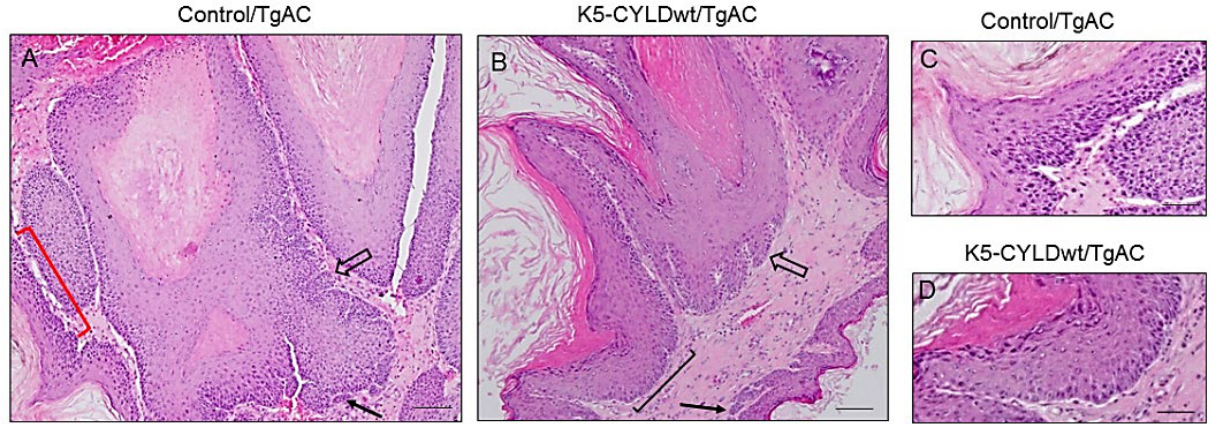
Figure 6. Histology of tumors developed by Control/TgAC and K5-CYLDwt/TgAC mice. Representative H&E staining showing the histology of tumors collected 17 weeks after TPA treatment. ( A , B ) Both tumors have a papillary exophytic growth with high cellularity and hyperkeratosis. Back arrows point to microinfiltration foci; open arrows indicate epithelial extensions that project into the dermis (rete pegs); red bracket in ( A ): basal hyperplasia; black bracket in ( B ): non-hyperplastic basal layer. ( C , D ) Magnification showing the basal hyperplasia in the Control/TgAC tumor ( C ) versus no hyperplasia in the basal layer of the K5-CYLDwt/TgAC tumor ( D ). Scale bars: 60 µm ( A , B ); ( C , D ) 30 µm.